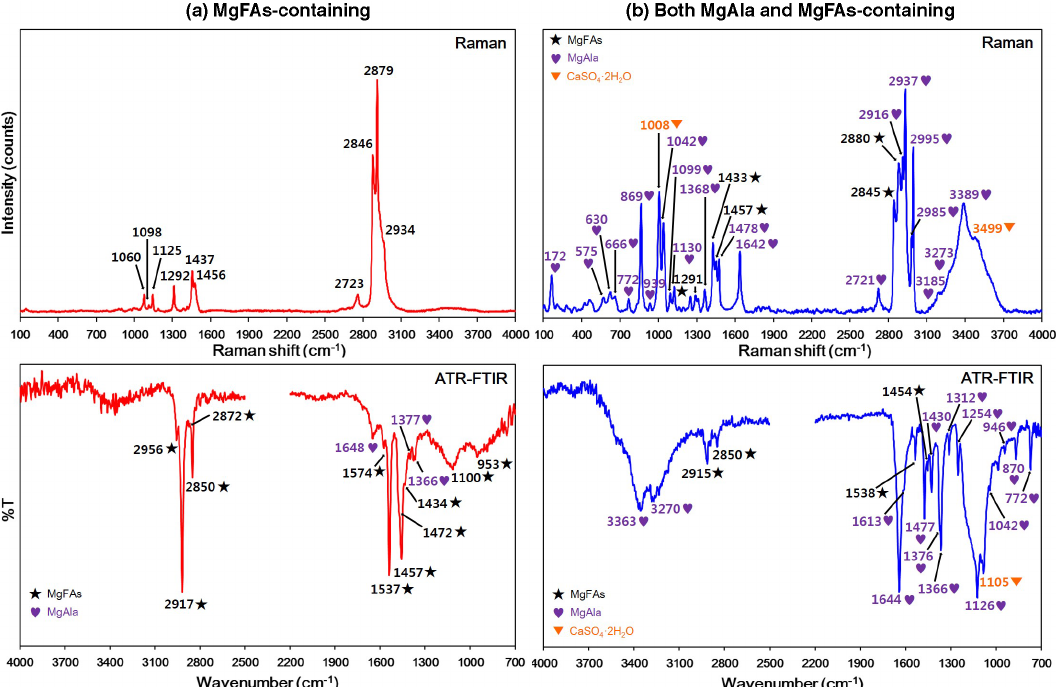
Figure 5. Raman and ATR-FTIR spectra of two typical individual wintertime SSAs. The ATR-FTIR data from the 2200–2390cm − 1 region, where atmospheric CO 2 peaks are present, were deleted for